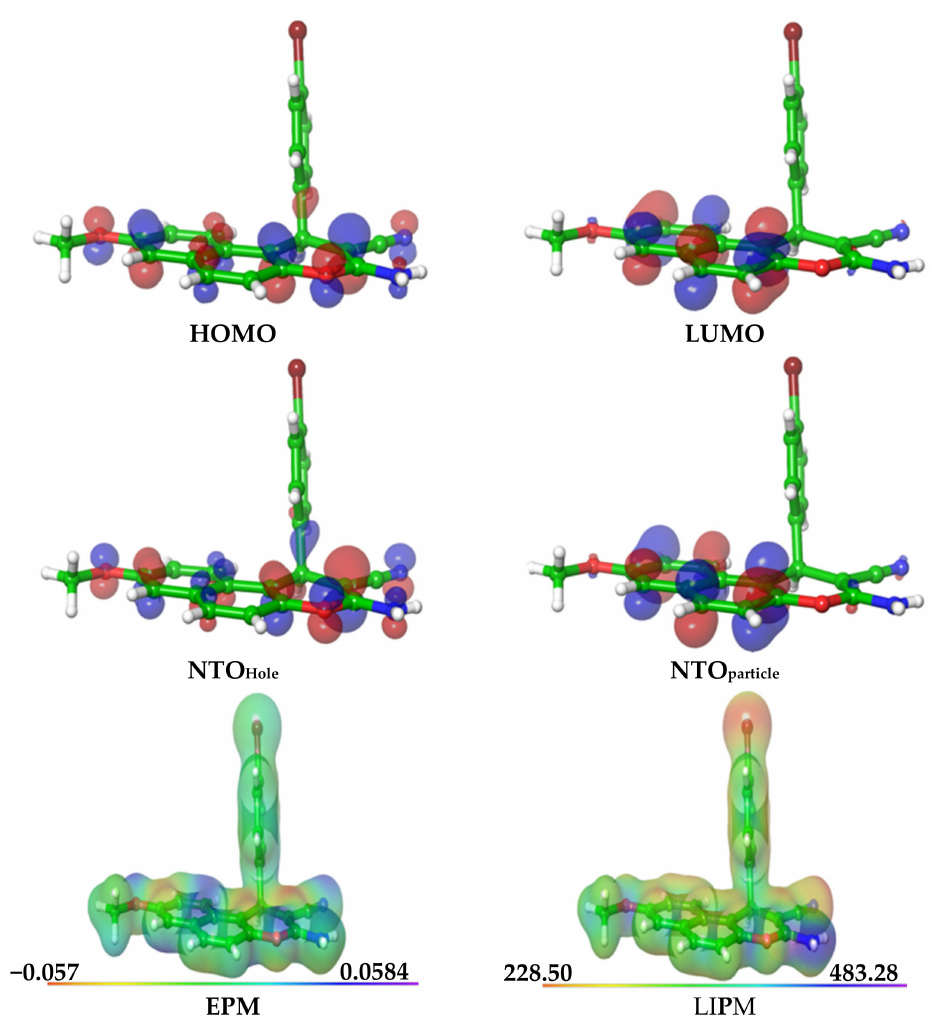
Figure 6. FMO of molecule 4 includes HOMO, LUMO, EPM, and LIPM. The different parameters of GR were calculated as follows: “ η , hardness”; ”S, softness”; ” χ , electronegativity”; ” ω , electrophilicity index”; “ ε I, nucleophilicity index”; ”I, ionization potential”; ”A, electron affinity”; ” ∆ E B − D , energy back donation”; “ ∆ N max , maximum amount of electron transfer”. The low “ ∆ G , energy gap” reflects the high stability with the reactivity